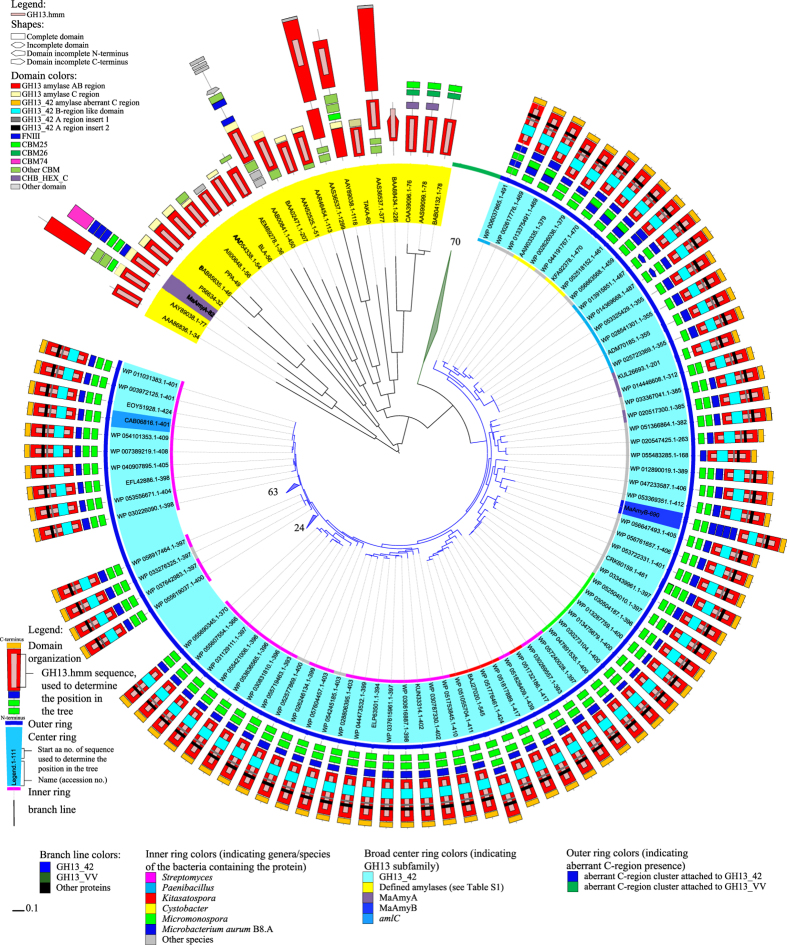
Phylogenetic tree of MaAmyB plus its 164 homologs, and a selection of members from the defined GH13 subfamilies that are either associated with EC3.2.1.1 or EC3.2.1.982 (see Supplementary Table S1).The tree is based on the alignment of the catalytic AB-regions (GH13.hmm) as obtained from dbCAN. Domain organization shown is based on a combination of CDD and dbCAN data. The inserts in the A-region, the B-region and aberrant C-region as indicated are based on BLAST results of the identified regions from MaAmyB. Subfamily information was obtained from CAZy. Aberrant C-region information was obtained from Supplementary Fig. S2. The number 70 shows the location of a cluster of 70 putative α-amylases that share the aberrant C-region with the MaAmyB homologs but do not belong to subfamily GH13_42 (designated as GH13_VV) (see Supplementary Figs S2 and S3). At numbers 24 and 63, clades with these numbers of sequences similar to the nearby shown sequences have been collapsed to improve the readability of the tree. CBM74 is a novel CBM domain in MaAmyA15.